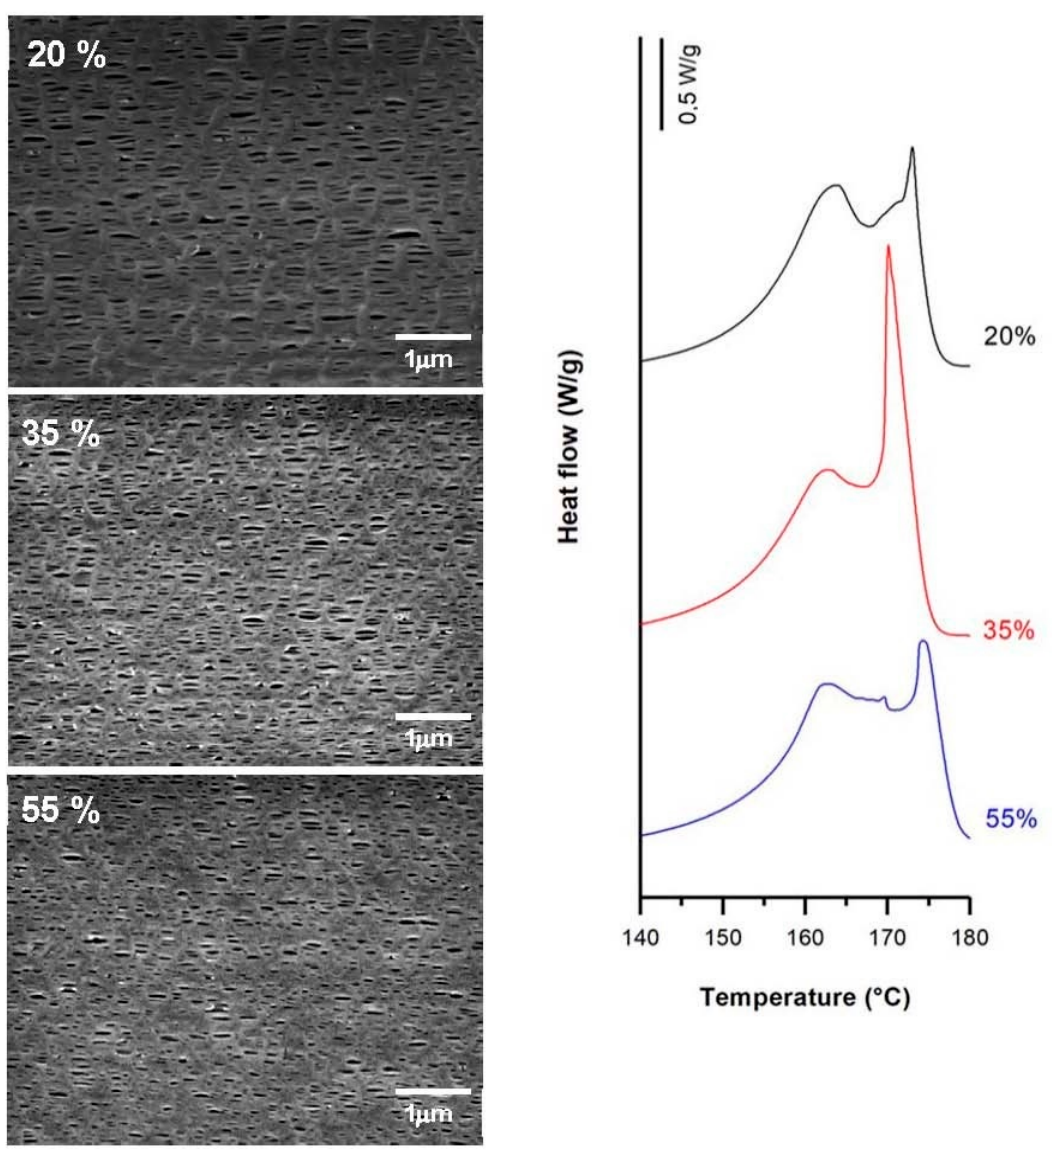
Figure 11. Influence of cold strain extent. Common uniaxial strain conditions. Cold stage, 1.0 mm/min; hot stage, 1.0 mm/min,